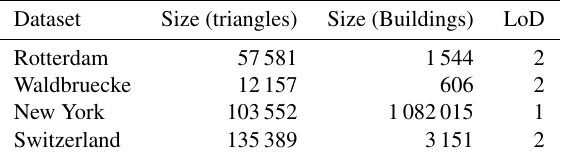
Table 1: 3D city models used for testing the performance of the method.